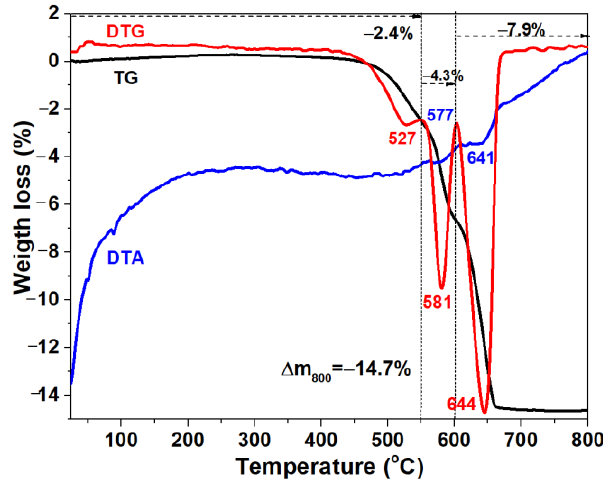
Figure 7. The thermal behavior (TG, DTA, and DTG curves) of CBO-450.